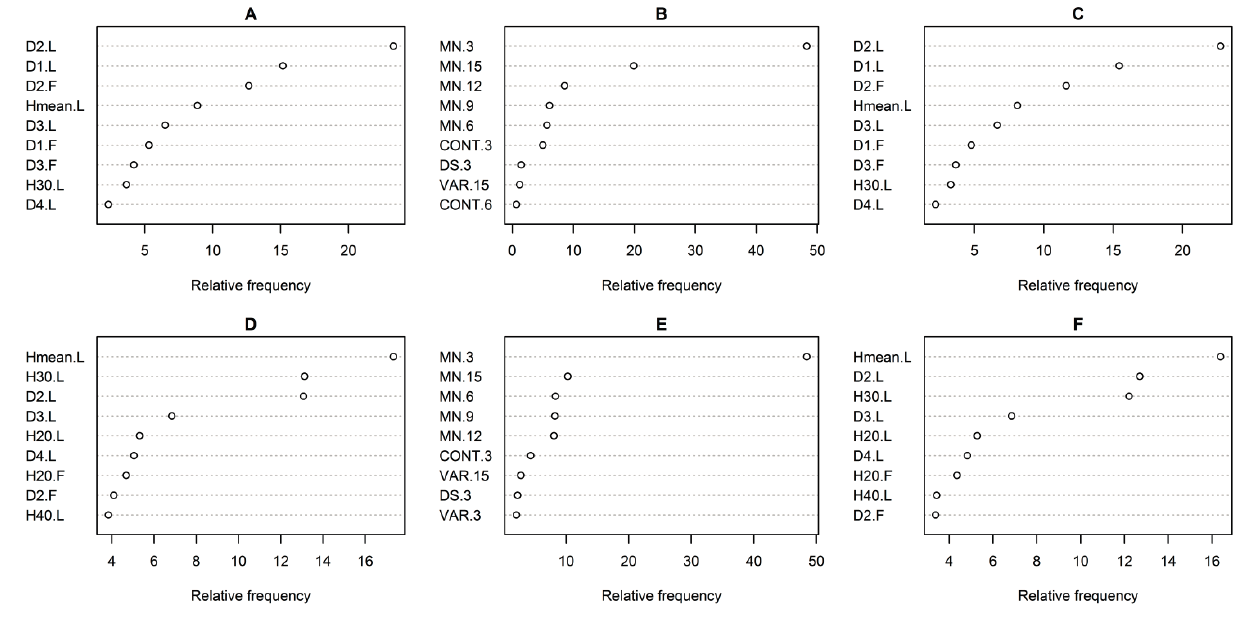
Figure 3. Dotchart of the relative frequency of the nine most frequently selected predictor variables in a simple linear model fitting procedure with logarithmic ( A–C ) and square root transformation of the response ( D–F ) in combination with vertical variables (A, D), texture variables (B, E) and both vertical and texture variables (C, F). Variables are explained in Section